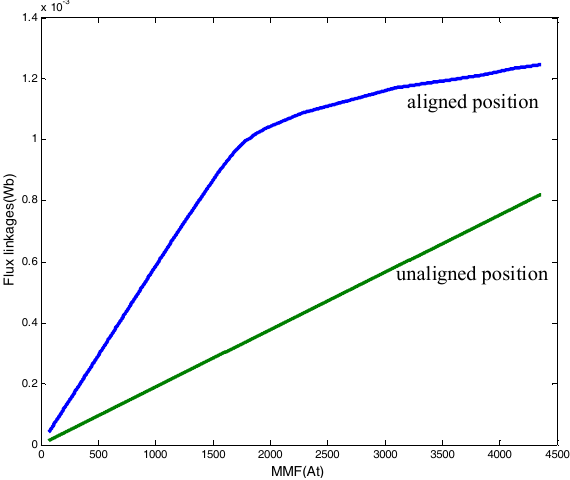
Figure 17. Flux linkages corresponding to MMF of aligned and unaligned positions.